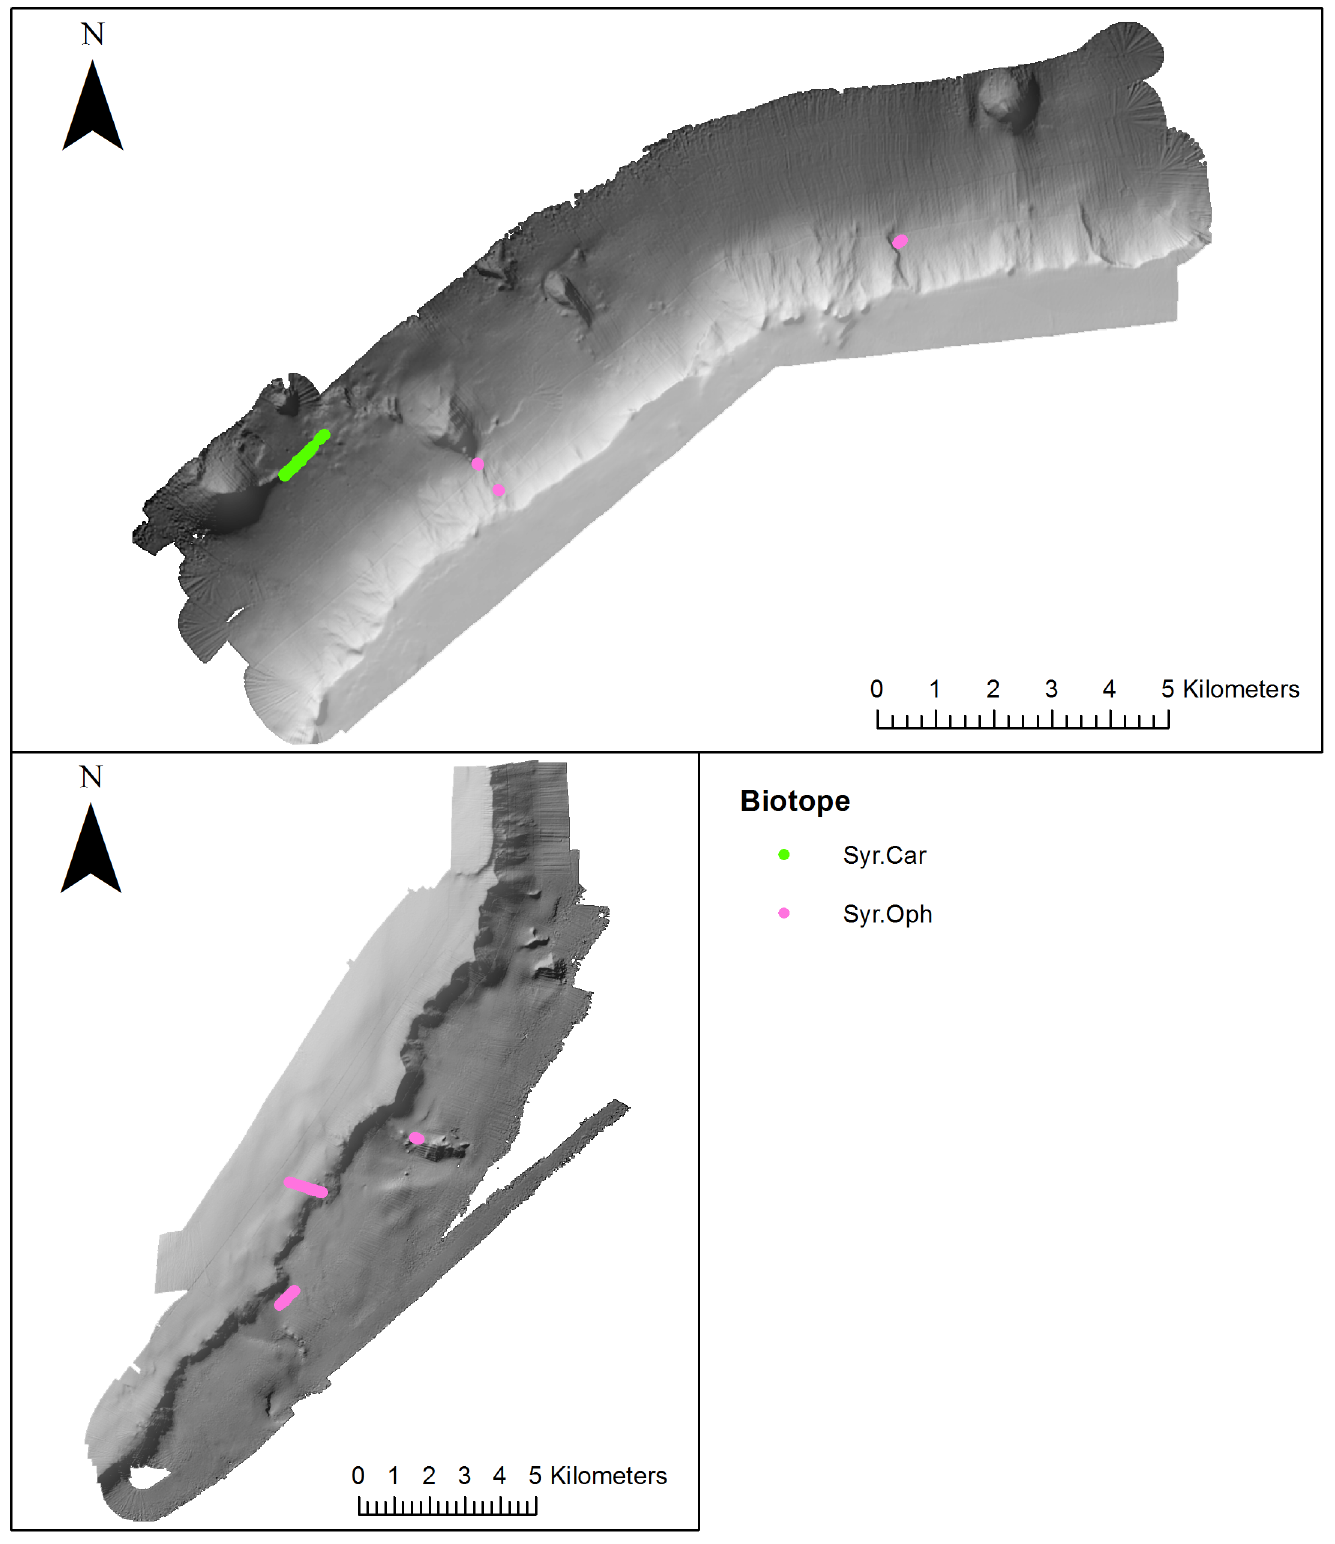
Fig 8. Distribution of xenophyophore communities (mapped using video footage) biotopes on the NW and SE side of Anton Dohrn Seamount. Refer to Fig 2 for bathymetric scale.